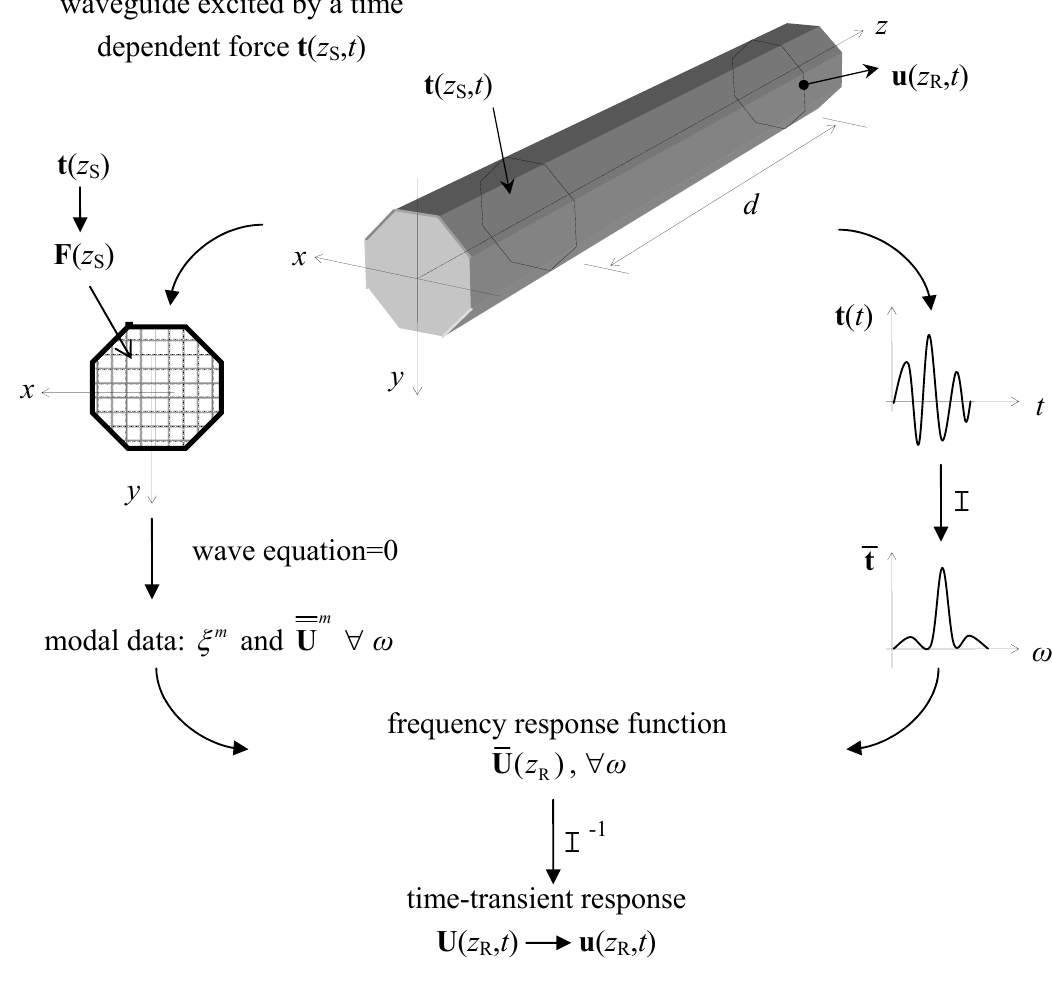
Figure 1 . Schematic representation of the overall